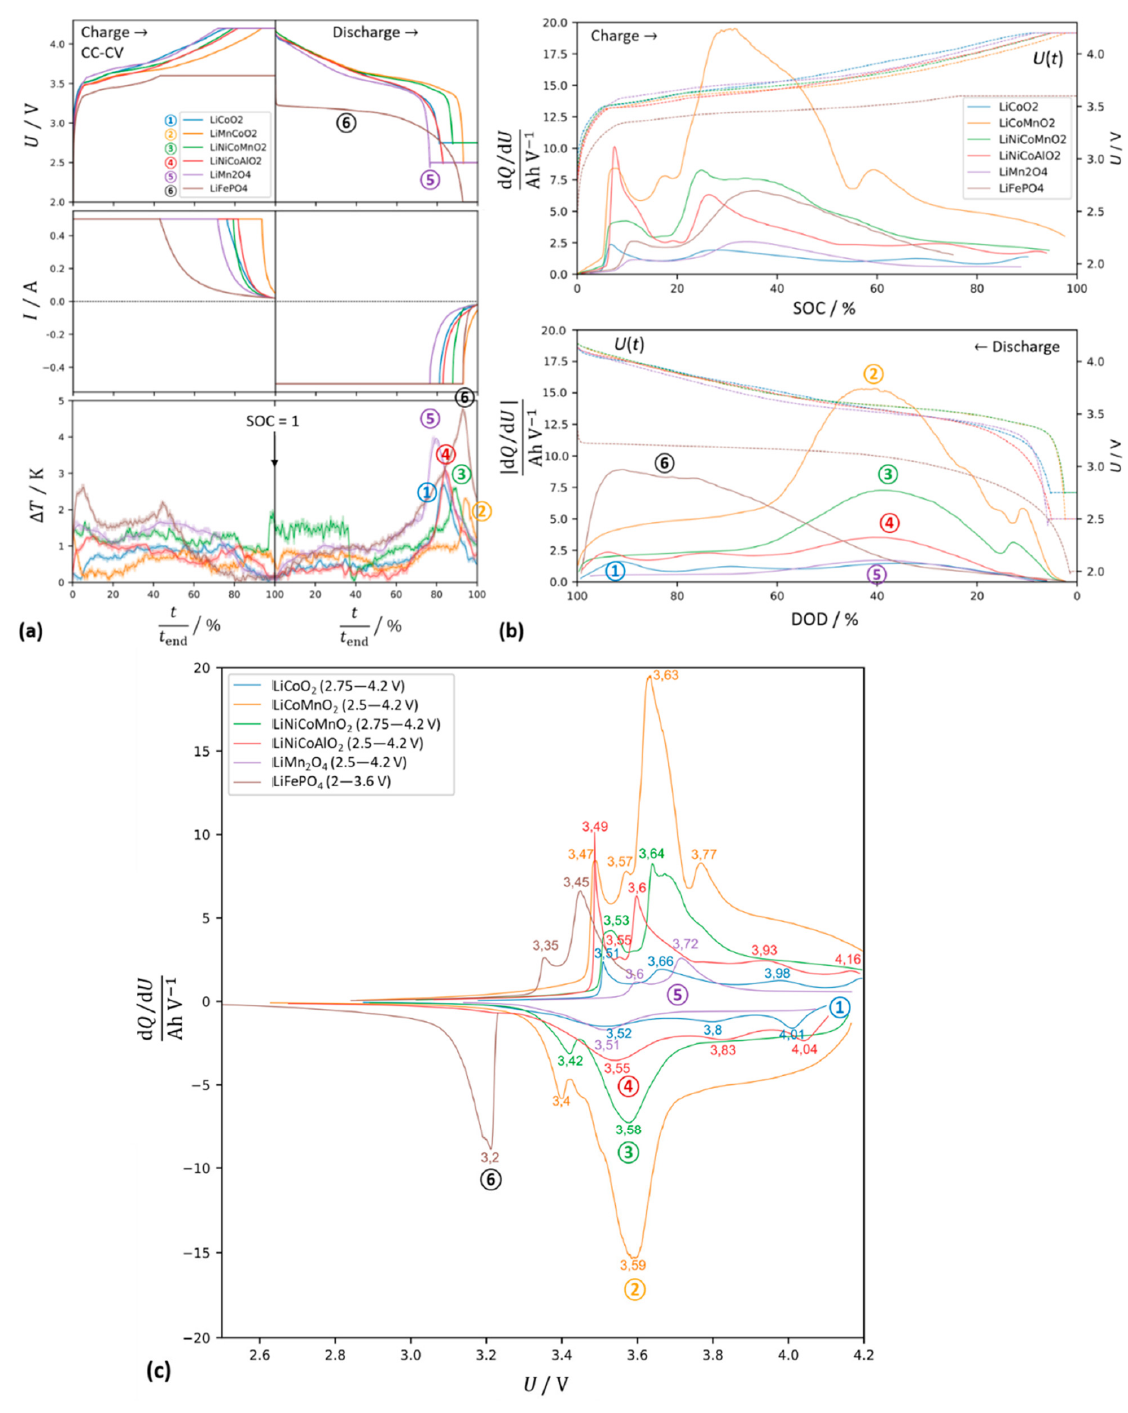
Figure 6. ( a ) Charge–discharge characteristics of different lithium-ion battery cell chemistries; cell voltage U , current I , and temperature change Δ T versus time t . ( b ) Differential capacity d Q /d U as a function of state-of-charge (SOC = Q / Q 0 ) and depth-of-discharge (DOD = 1 − Q / Q 0 ). ( c ): Differential capacity, d Q /d U = I (d U /d t ) − 1 , as a function of cell voltage U (voltage change d U /d t ) for constant current charge and discharge ( I = constant). The redox peaks mainly show the lithiated and delithiated metal oxide cathode (+) against the lithiated graphite anode ( − ). Redox processes: 1 (cid:13) 2 (cid:13) 3 (cid:13) Co 2+ → Co 3+ → Co 4+ (3.5–4 V, e.g., Li 0.93 CoO 2 → Li 0.73 CoO 2 → Li 0.5 CoO 2 ), 4 (cid:13) Ni 2+ → Ni 3+ 2+ → → Ni 4+ (3.8–4.2 V), 5 (cid:13) Mn 2+ → Mn 3+ → Mn 4+ (3.5–3.7 V, e.g., LiMn → Li 2 O 4 0.2 Mn 2 O 4 ), 6 (cid:13) Fe Fe 3+ (3.2–3.5